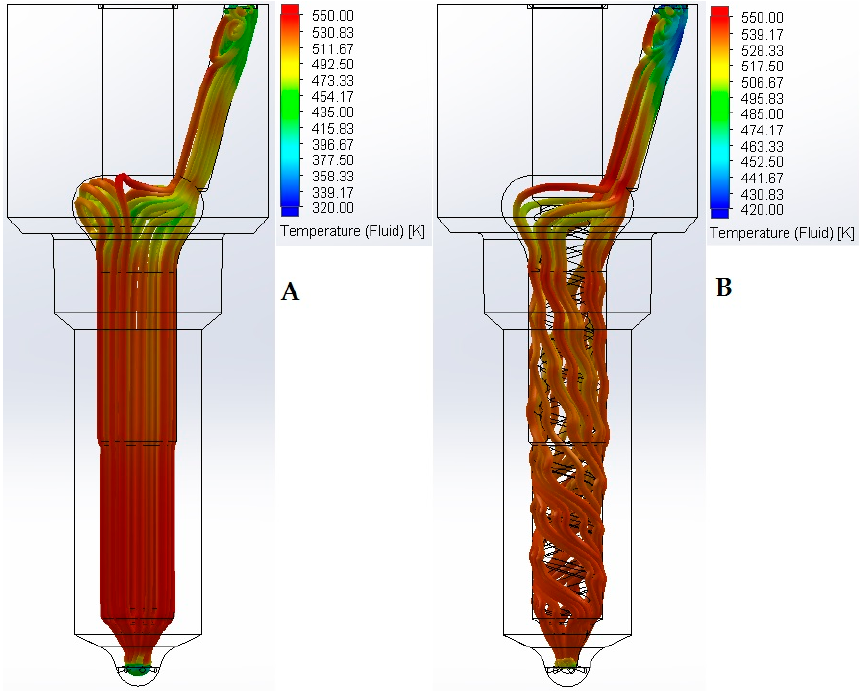
Figure 8. The results of preliminary simulation studies of the flow and temperature distribution of the fuel through the standard and modified atomizer. Flow parameters: injection dose: 0.7 mm 3 /H, injection time: 420 µ s, pressure in the system: 30 MPa. ( A ) Standard atomizer; ( B ) modified atomizer.